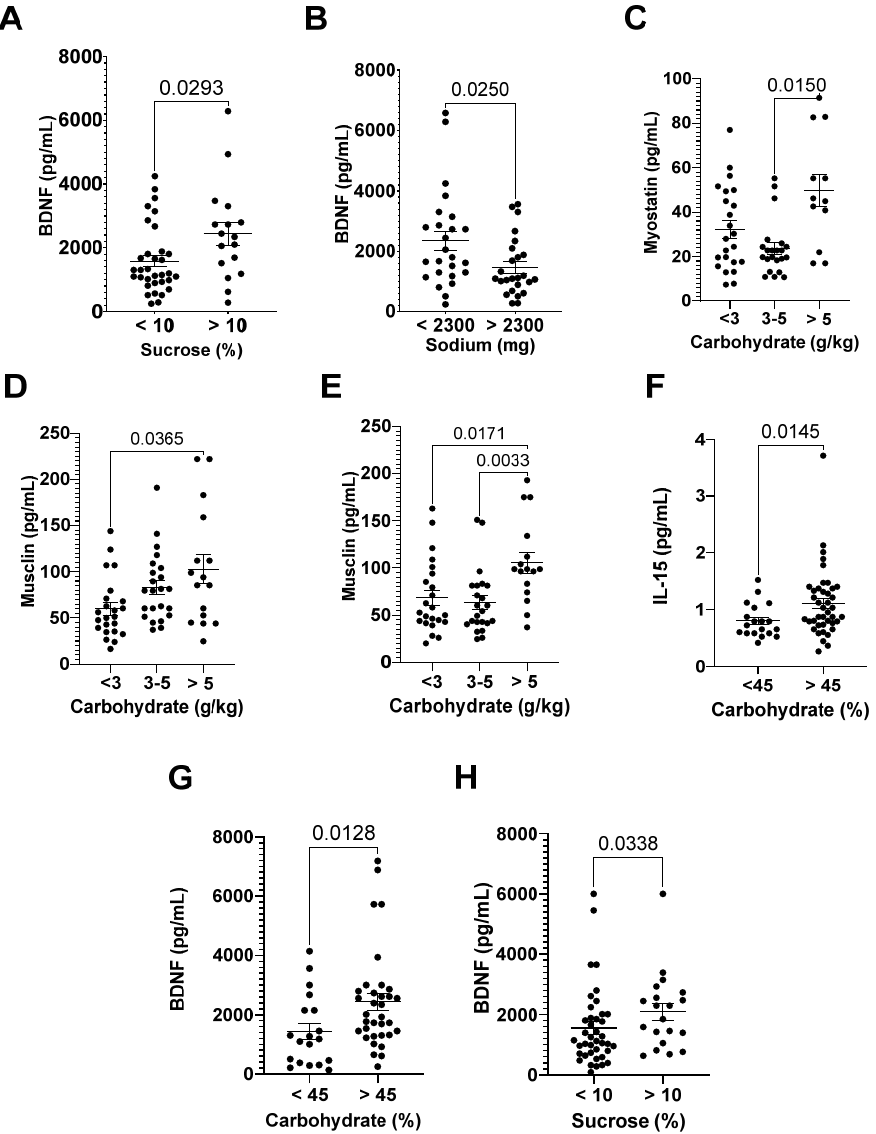
Figure 3. Dietary intake and myokine levels after the race and in the recovery period. The BDNF levels before the race ( A , B ), myostatin levels 72 h after the race ( C ), and musclin levels 24 h after ( D ) the race ( E ); IL-15 levels 24 h after the race ( F ); and BDNF levels 72 h after the race ( G ) and 24 h after the race ( H ). The myokine levels are presented as mean ± EPM, as well as individuals’